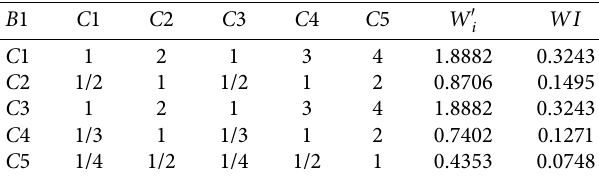
Table 3: B 1- C judgment matrix. Table 4: B 2- C judgment matrix.